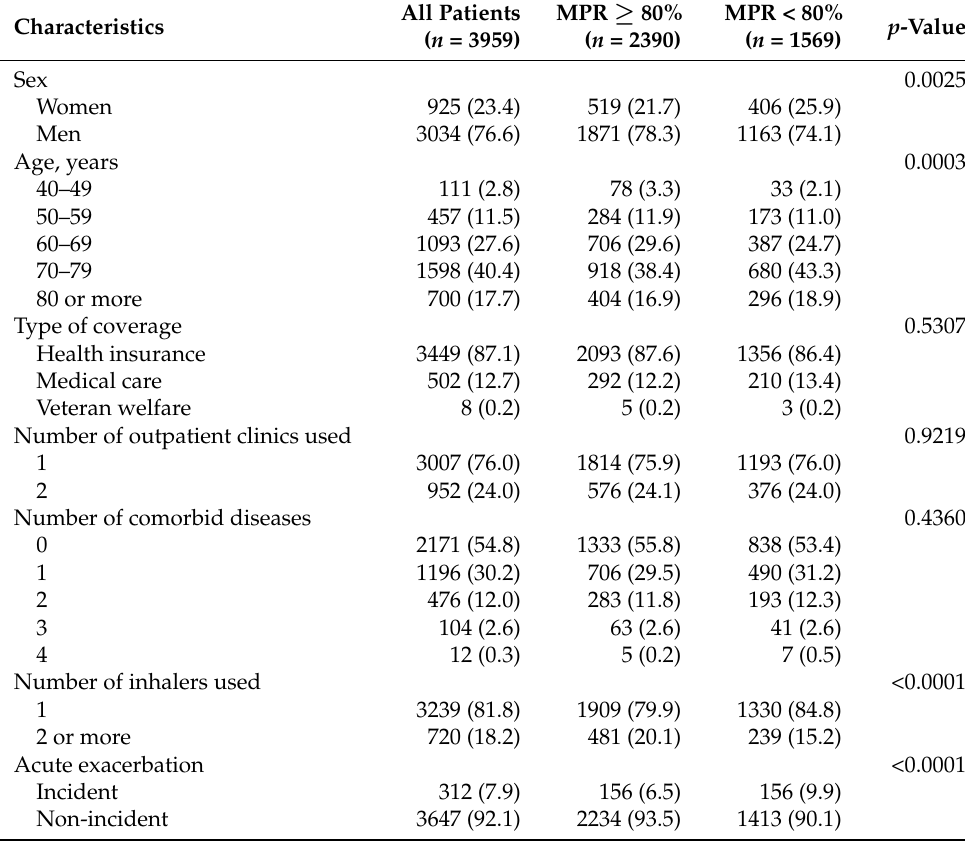
Table 1. Clinical characteristics by medication adherence for patients with COPD naïve to long-acting